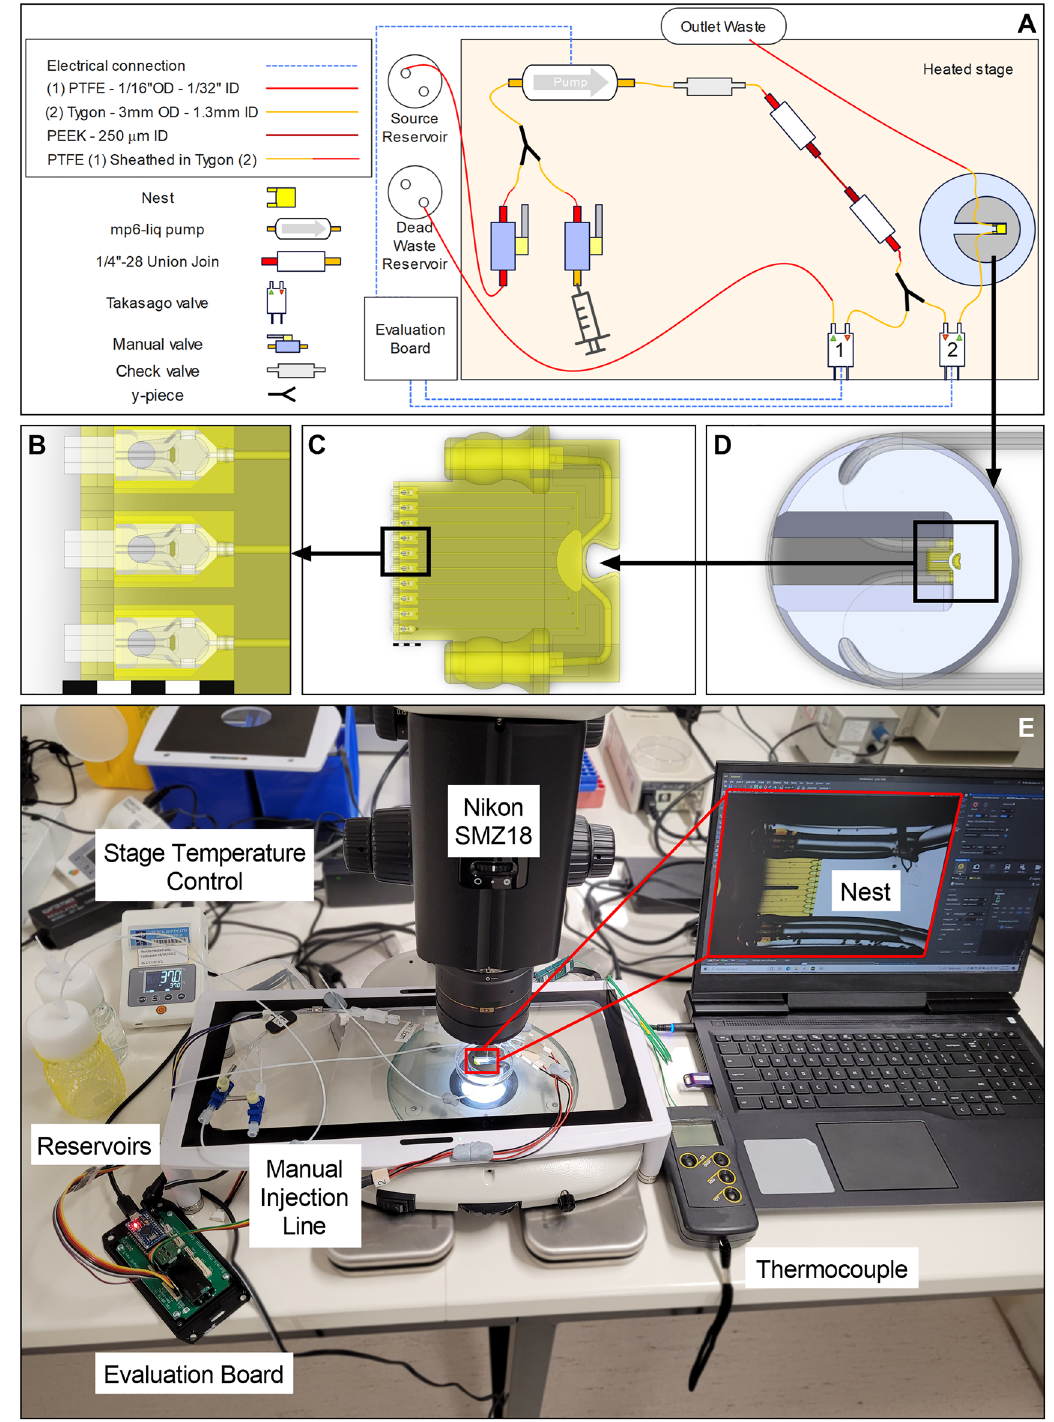
Figure 2. Microfluidic testbed for nest-cradle device (Scale bars = 1 mm). ( A ) Diagrammatic representation of testbed components (components and positions are not to scale); ( B ) Zoom in on model of three central cradles inserted into the nest, which acts as the roof with cell loading holes for each cradle; ( C ) Zoom in on model of the whole nest with ten cradles inserted; ( D ) Model of nest with tubing attached secured by titanium holder in 60 mm petri dish; ( E ) Photographic image of testbed set up in the laboratory with a Nikon SMZ18 stereomicroscope. An Olympus IX83 inverted microscope was used in place of the SMZ18 for particle tracking